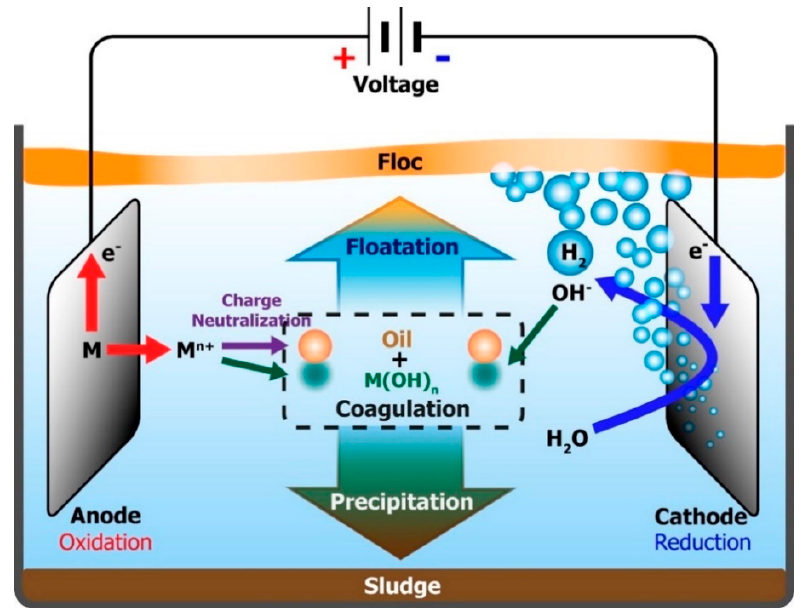
Figure 4. Electrochemical (ET) system for oily wastewater treatment. Reprinted with permission from ref. [54]. Copyright 2016 Elsevier B.V.